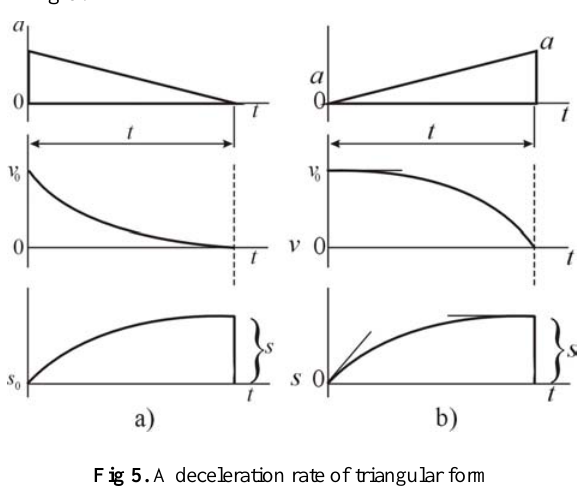
Rate of deceleration with a triangular form is shown in Fig 5.